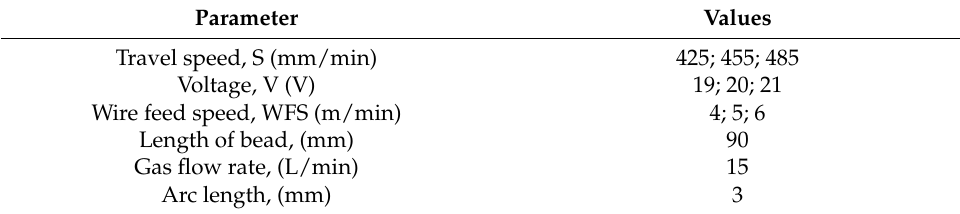
Figure 1. Experimental setup of the WAAM process. Table 2. Experimental conditions of WAAM